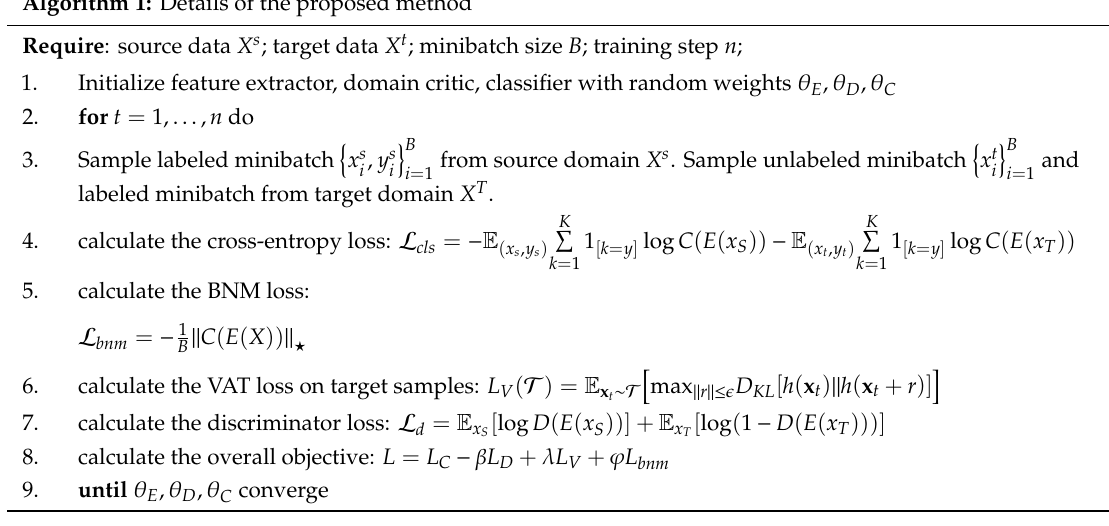
Algorithm 1: Details of the proposed